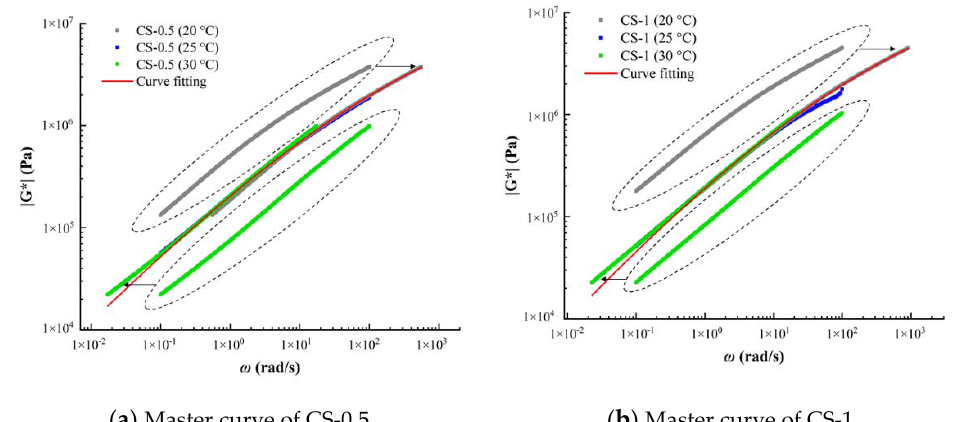
Table 8. Master curves fitting parameters.